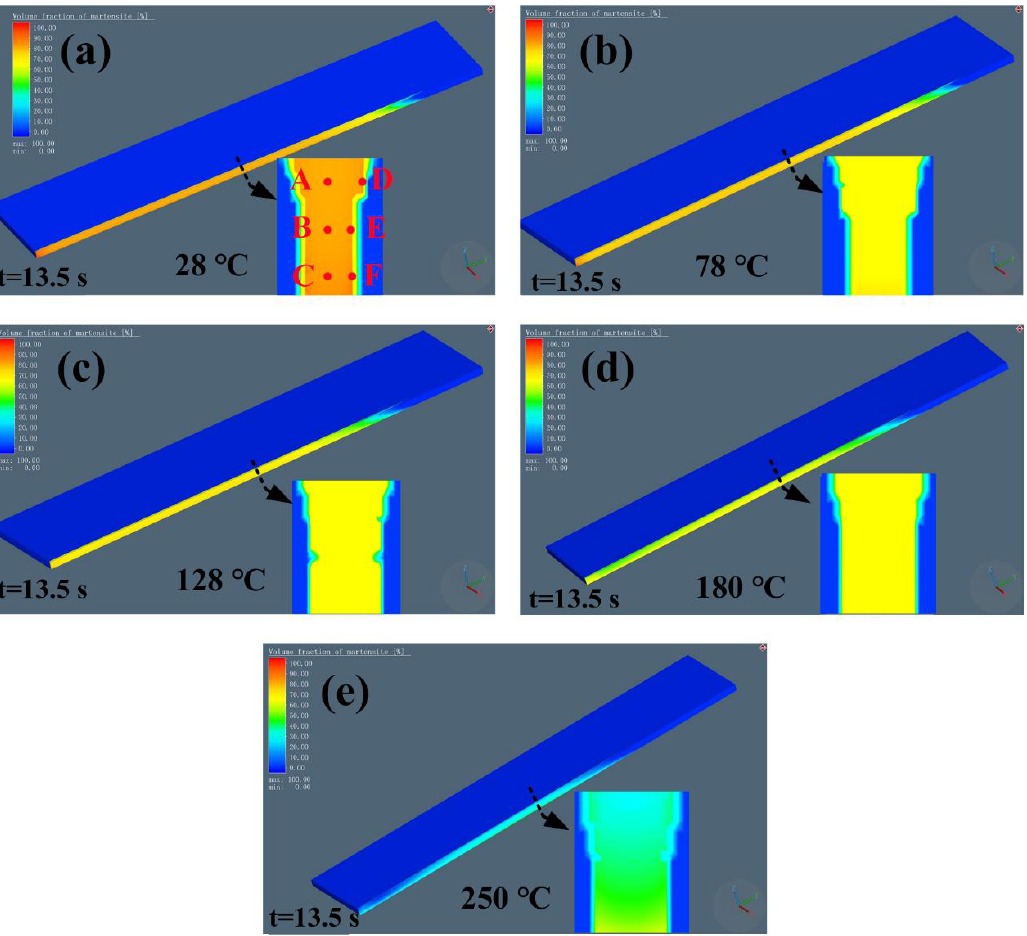
Figure 7. Simulated martensitic contents at different preheating temperatures. ( a ) 28 °C; ( b ) 78 °C; ( c ) 128 °C; ( d ) 180 °C; ( e ) 250 °C.